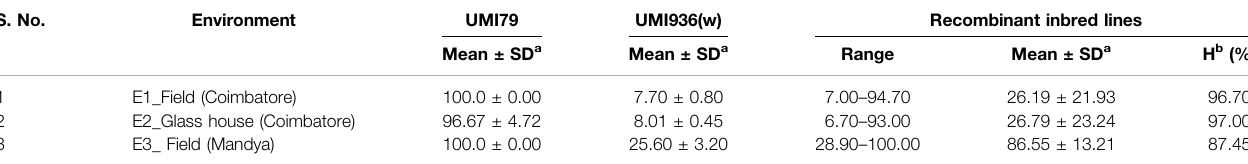
TABLE 1 | Descriptive statistics and heritability on sorghum downy mildew disease incidence in recombinant inbred line (RIL) population derived from a cross of UMI79 × UMI936 (w) over the three environments. S.